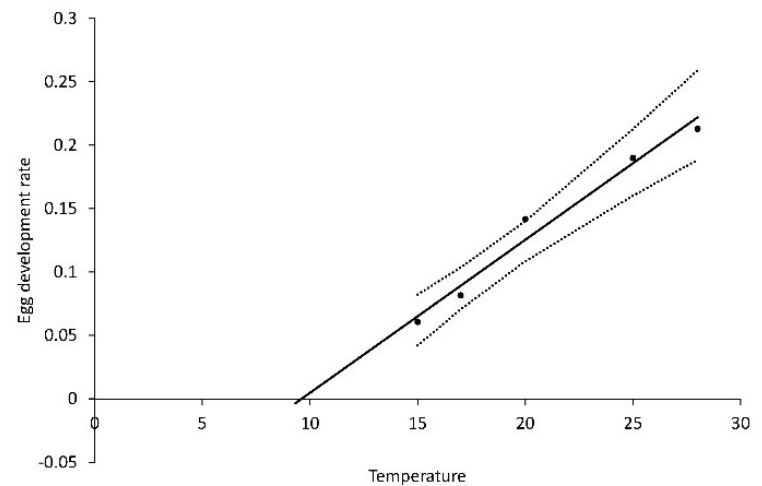
Figure 8. Temperature dependent development of eggs of Agrotis segetum at five temperatures; R leggs = 0.1130 + 0.00121T (°C), R 2 = 0.854, p = 0.0001. The dashed lines above and below represent the upper and lower 95% confidence bands.